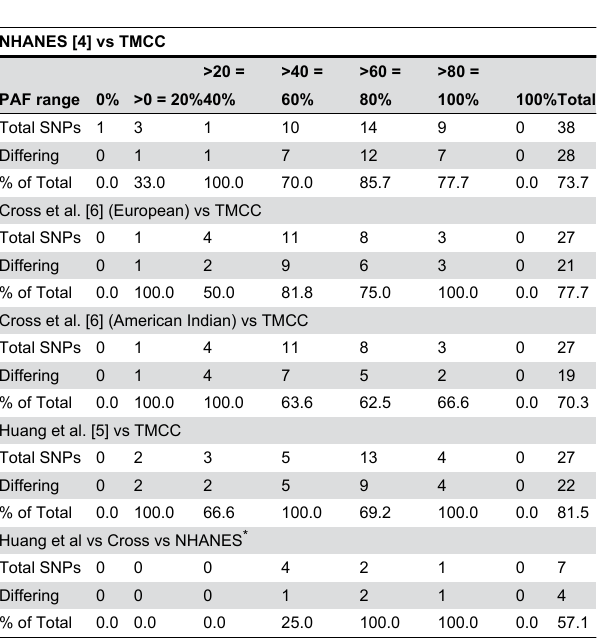
Table 1. Comparisons between TMCC and European PAFs reported in the